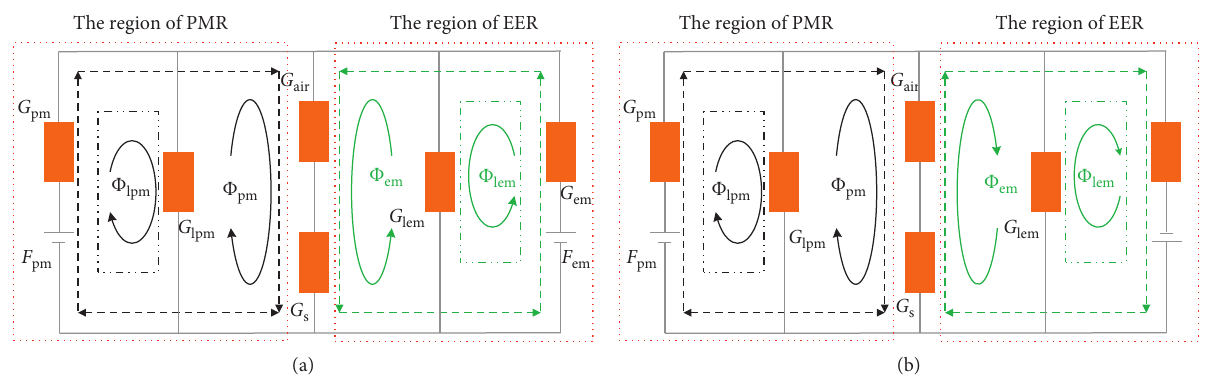
Figure 3: Equivalent magnetic circuit model of synthetic magnetic field. (a) With forward excitation current. (b) With reverse excitation